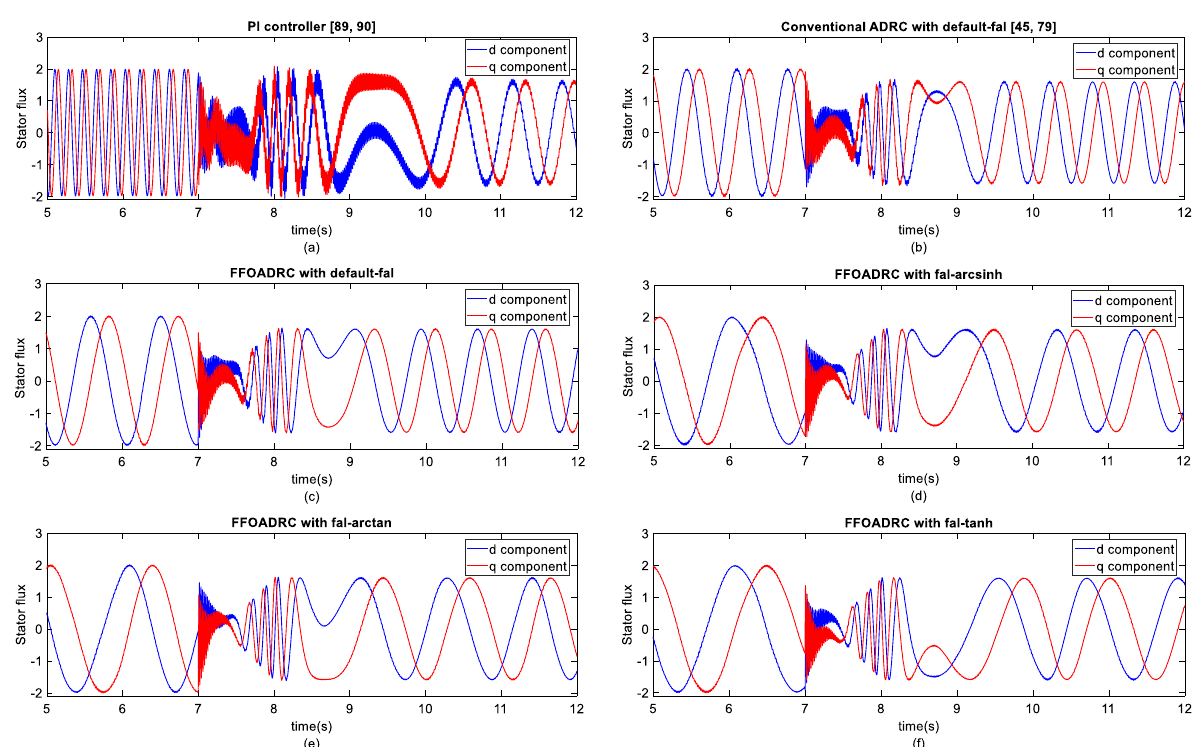
0.8 Ω: ( a ) PI controller [89, 90], ( b ) Conventional =